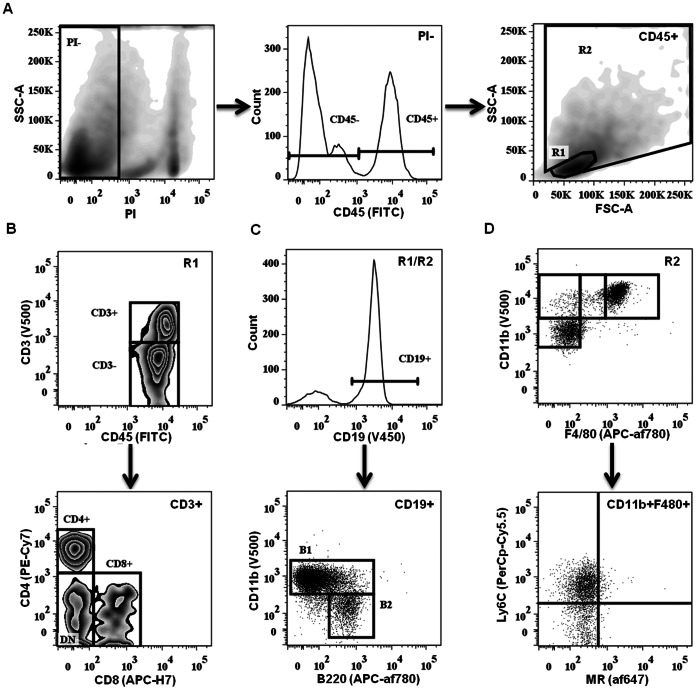
Flow cytometric analysis gating strategy.(A) Digested tissue samples were subjected to PI live/dead cell exclusion and CD45+ leukocytes were divided into R1 (lymphocytes) and R2 (mono-, granulocytes) gates based on forward/side scatter followed by doublet exclusion. (B) CD3+ T cells from R1 were further subclassified either as CD4+ TH, CD8+ TC or DN (double negative). (C) CD19+ B cells from R1 and R2 were further subclassified into CD11b+ B1 or CD11b− B2. (D) Monocytic populations from R2 were classified based on CD11b, F4/80 and CD11c (not shown) staining, and further subdivided based on activation markers.